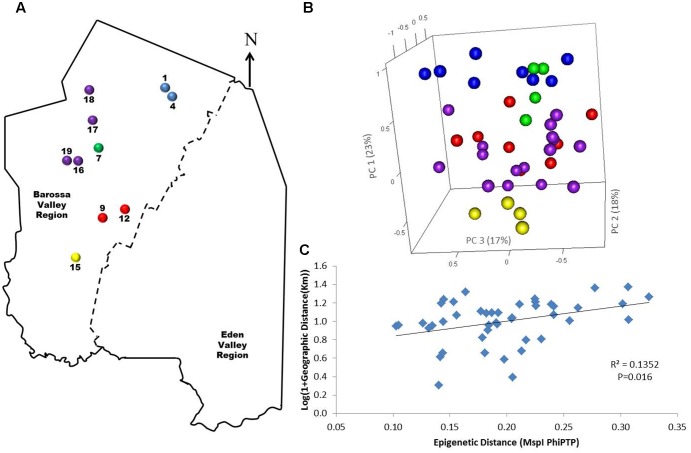
Analysis of the correlation between molecular differentiation and geographic distance (Km) of vineyards planted with clone 1654 in the Barossa region. (A) Location of the selected Barossa Valley vineyards from the three sub-regions distributed along the Barossa Valley North–South axis Northern Grounds (blue), Central Grounds (green), Eastern Edge (red), Southern Grounds (yellow), and Western Ridge (purple). Arrow indicates the direction of geographic North. (B) PCoA representing genetic/epigenetic differences between leaf samples collected from four plants/vineyard. Percentage of the variability captured by each PC is shown in parenthesis. (C) Correlation between pairwise genetic/epigenetic distance (MspI PhiPT) and geographical distance [Log(1 + GeoD) (km)] between vineyards. Shown equations are the correlation’s R2 and the Mantel test significance (P-value was estimated over 9,999 random permutations tests). PCoA and PhiPT for Mantel test were based on presence/absence of 215 loci obtained from MSAP profiles generated using MspI.